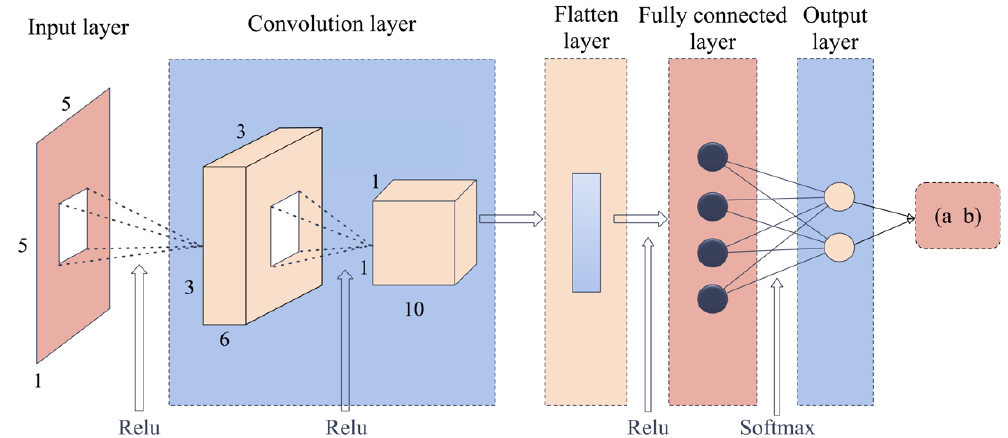
Figure 8. One of the Convolution Neural Network (CNN) architectures, including the input layer, two convolution layers, one fully connected layer, and the output layer.